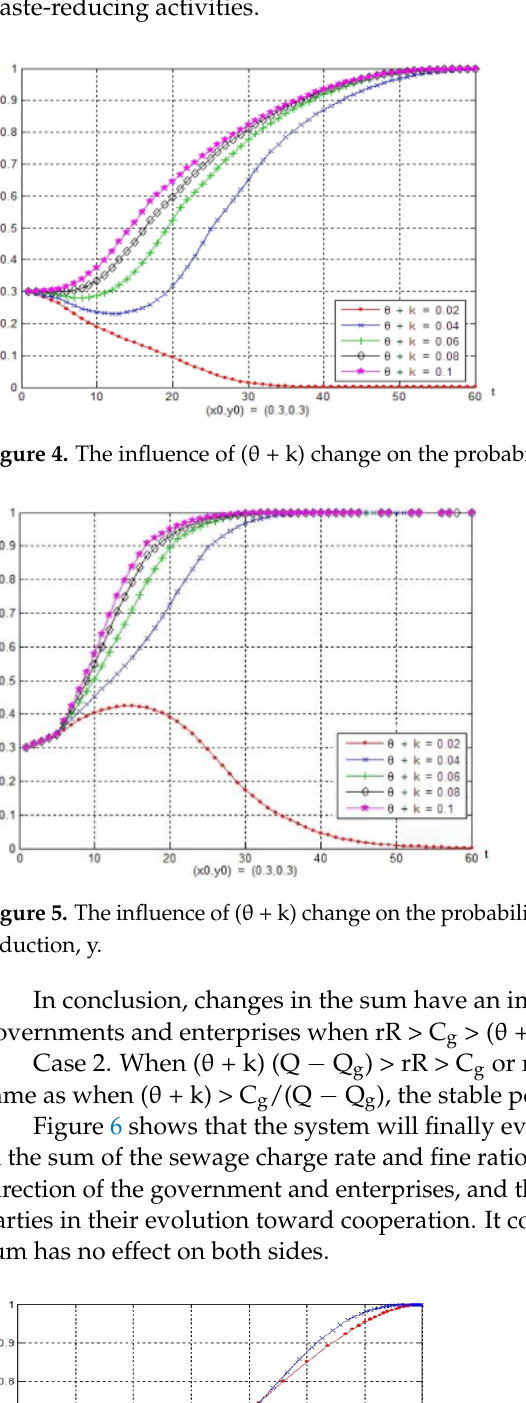
Figure 4. The influence of (θ + k) change on the probability of government inspections, x.